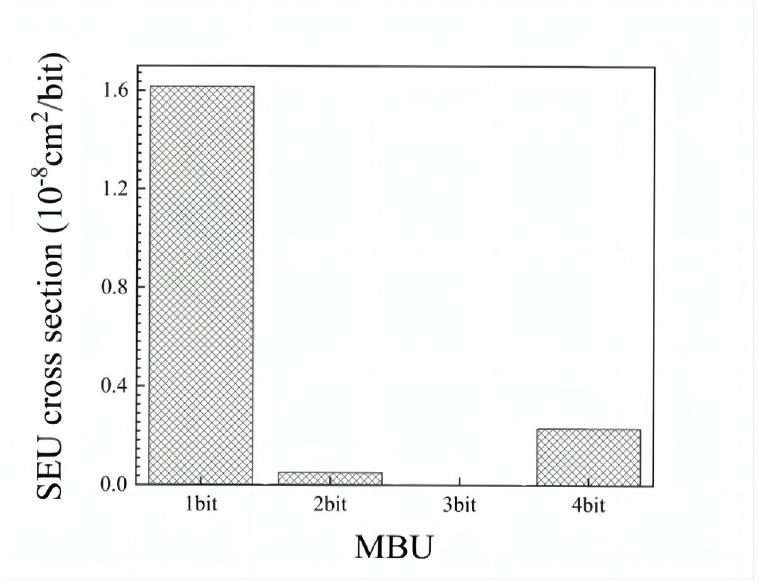
Figure 8. The cross section of the MBU for the CLM in the dynamic test.